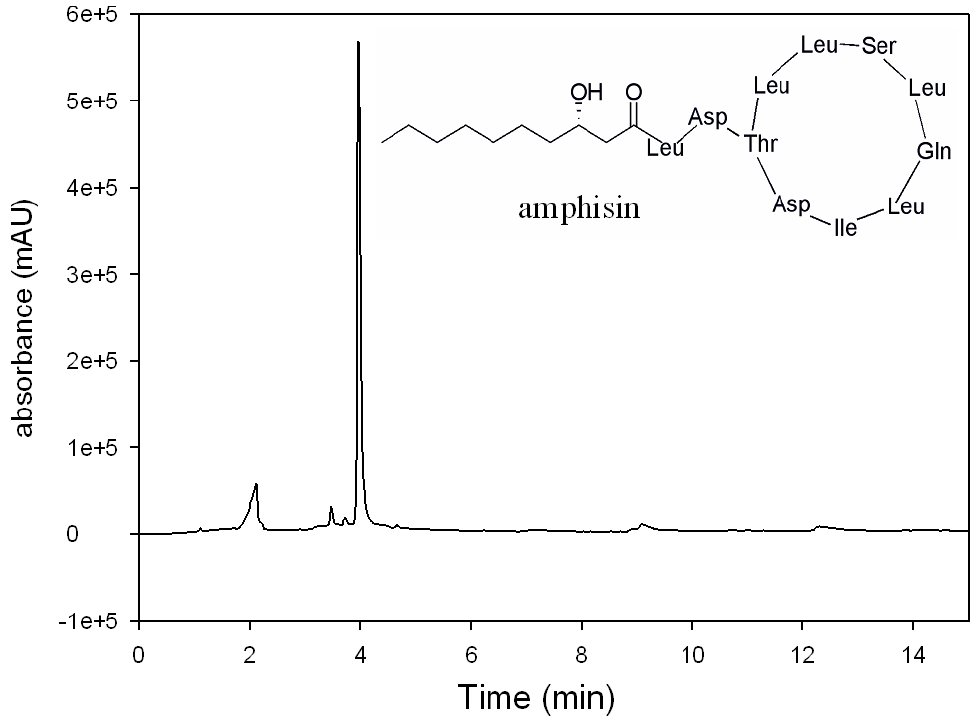
Figure 1. HPLC-UV chromatogram (λ = 210 nm) of the freeze dried biosurfactant produced by P. fluorescens DSS73, the amphisin and its